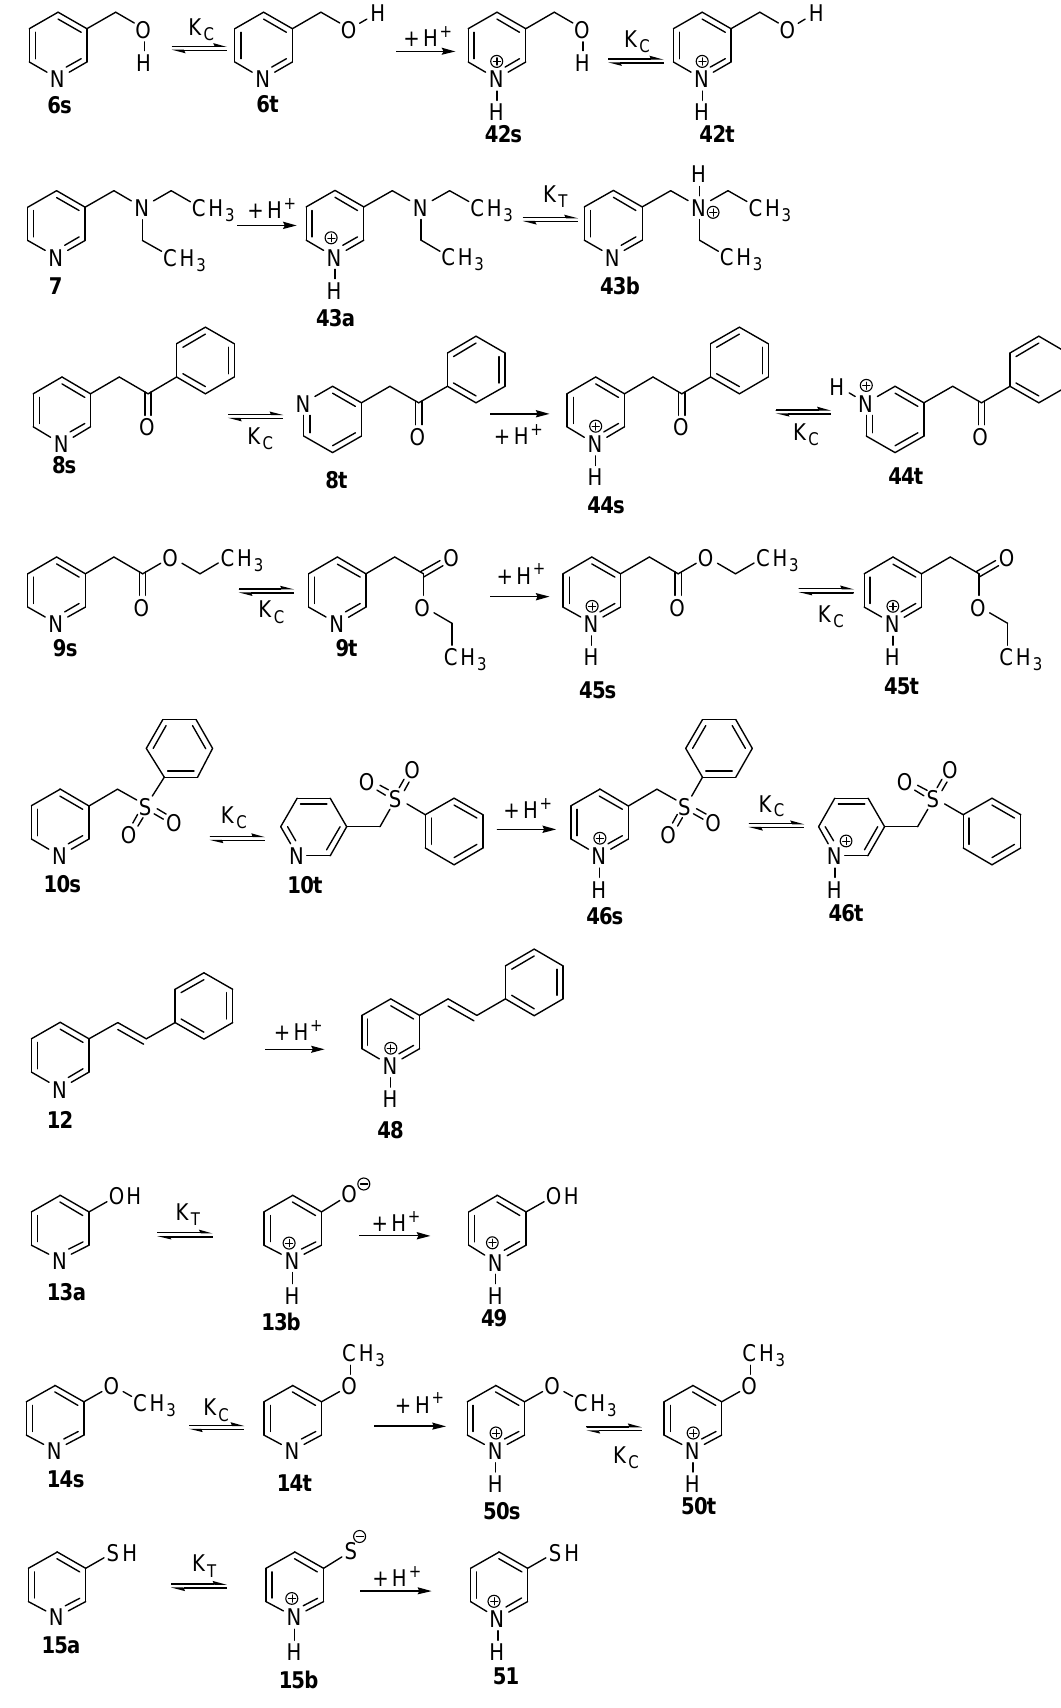
. Scheme 2 . The protonated forms of 3-substitued